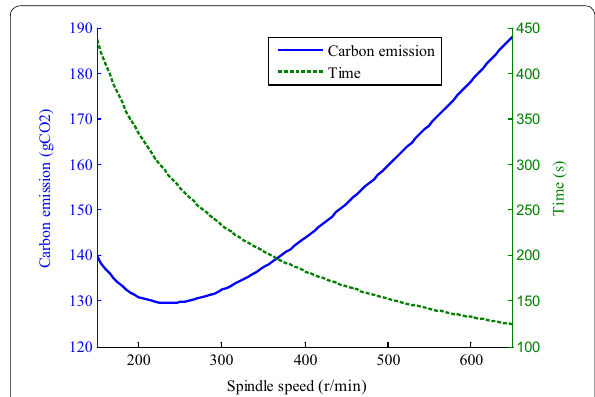
Figure 10 Influence of spindle speed on the optimization target